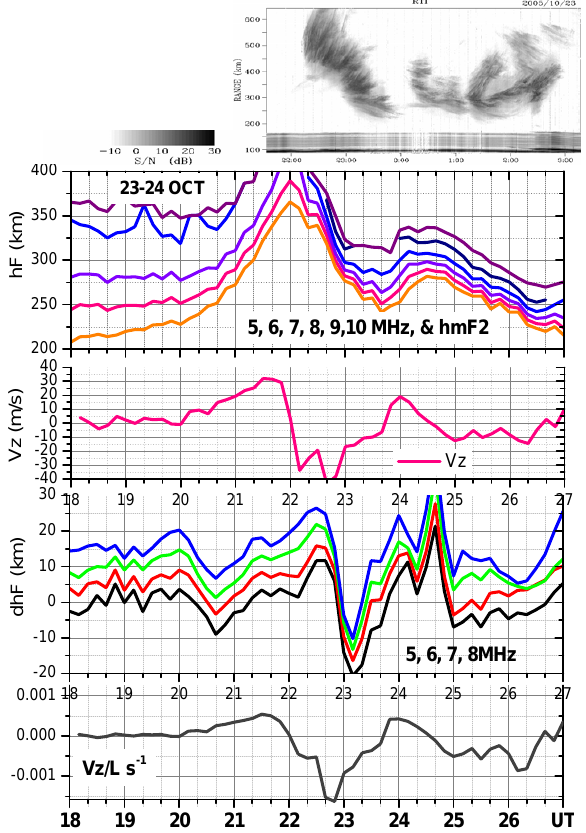
Fig. 2b Fig. 2a Fig. 2b. Plots similar to those of Fig. 2a, but for the evening-night Fig. 2a. Plots for the 23–24 October 2005. RTI map of 5-m irreg- period of 24–25 October 2005. ularity distribution as observed by the 30MHz radar over Sao Luis (top panel); F layer true heights at plasma frequencies 5, 6, 7 and 8MHz (panel 2 from top); Mean of the drift velocities calculated sunset (21:00 UT) did not present any clear downward phase as d(hF)/dt at frequencies 5, 6, 7, and 8MHz (panel 3 from top); Band-pass filtered (for 20-min. to 3-h periods) height oscillations propagation characteristics, indicating thereby rather weak at frequencies 5, 6, 7, and 8MHz (panel 4 from top); Instability GW activity as precursor to spread F. The lack of downward growth rate due to the term V z/L of the instability linear growth phase progression could mean little or no GW activity or in- rate factor (bottom panel). The “ V z ” in this and other figures is the sufficient measurement cadence because the GW frequency same as the “ V y ” in the text. GW would be close to evanescent mode and could contribute significant vertical motions, but without the telltale phase de- scent (see Fritts et al., 2008). In comparison to this, a clear can be verified from panel 4 in Fig. 2b that presents the height oscillations for 24–25 October. The PRE vertical drift on this evening attained a peak value of only 18 m/s by 21:00 UT ter 22:00 UT. The corresponding growth rate factor remained at 3 × 10 − 4 s − 1 or smaller from 20:50 until 21:50, then turn- ing negative after 22:00 UT. The development of the spread F at 22:15 as seen in the RTI map appears to be compati- ble with this growth rate. However, we will be showing later using model calculations, that spread F irregularities would not have occurred on this evening if the precursor GW char- acteristics were the same as they were on the evening of